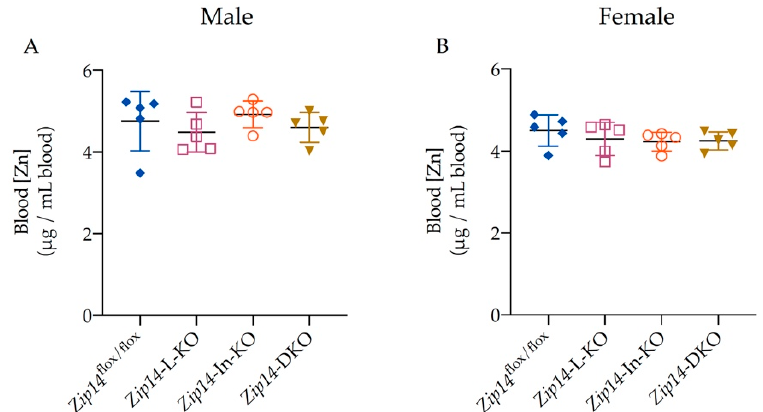
Figure 4. Tissue-specific Zip14 knockout did not alter blood zinc levels. Blood zinc (Zn) concentrations were measured by ICP-MS for ( A ) male ( n = 5) and ( B ) female mice ( n = 5). Data were expressed as mean ± SD and statistical analysis was performed using one-way ANOVA followed by the Bonferroni post-hoc test. No significant difference was observed between each group of Zip14 knockout and control mice.